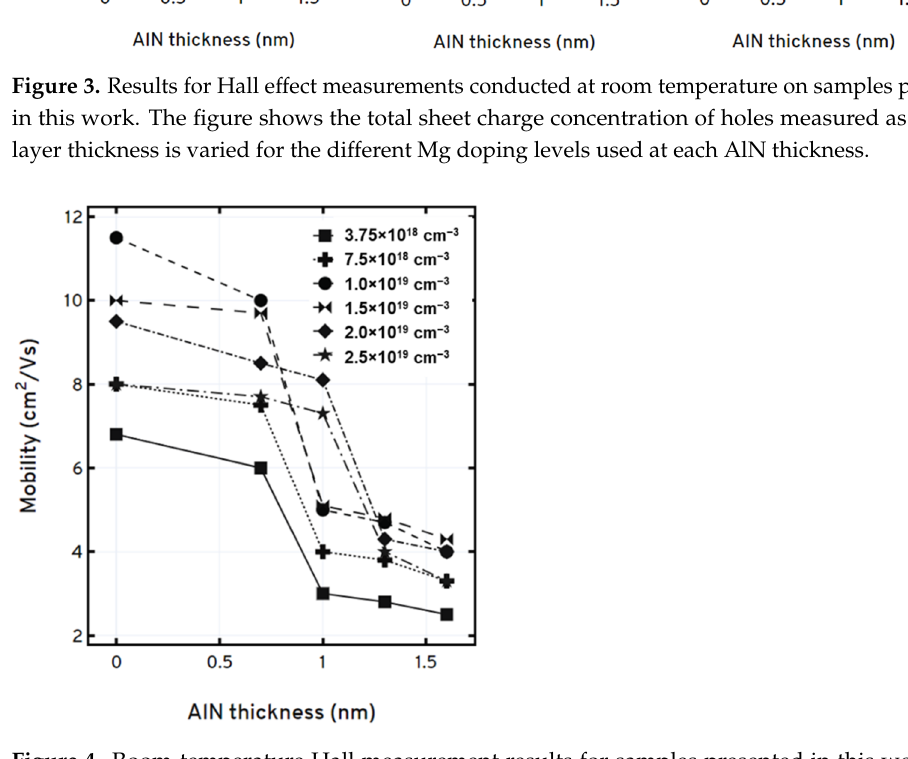
Figure 4. Room-temperature Hall measurement results for samples presented in this work. This figure shows the measured hole mobility as the AlN layer thickness is varied for the different Mg doping levels used at each AlN